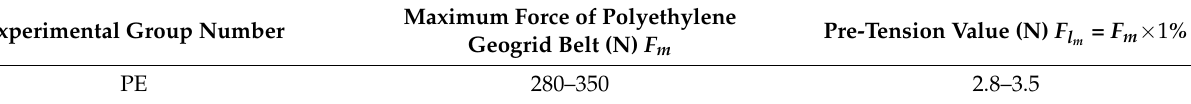
Table 3. Test pre-tension values of polyethylene geogrid belt.